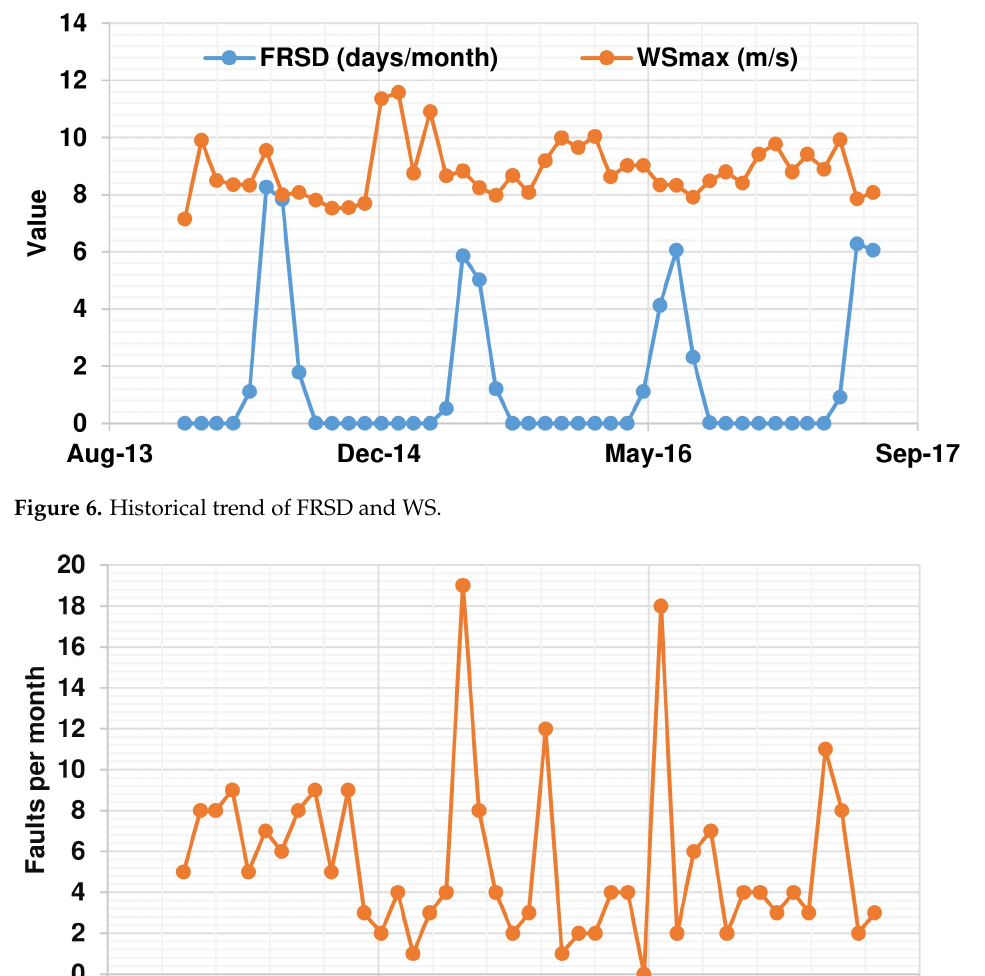
Figure 5. Historical trend of WAPD and WETD.